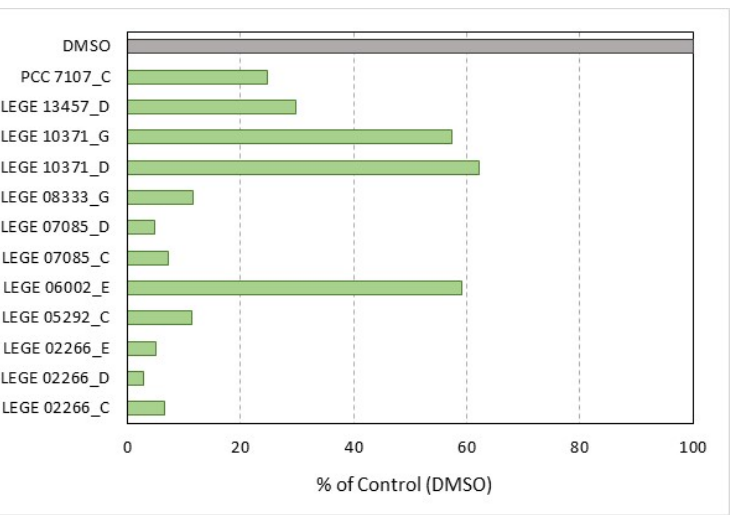
Figure 6. Firefly luciferase (Fluc) luminescence values observed in cells exposed to 12 specific fractions of 8 cyanobacteria strains. These values were particularly low when compared to solvent control (DMSO). Cells were transfected with the constitutively expressed vectors mpFN26A[Fluc/PPAR α ], mpFN26A[Fluc/PPAR β ] and mpFN26[Fluc; PPAR γ ] and pGL4.35[Nluc]. DMSO concentration did not exceed 0.5 % per well. Results are shown as percentage DMSO luminescence (100%). The strains identified to have low Fluc raw luminescence were looked at for the presence of cyanotoxins in the genus, but its presence is not documented [24], which may indicate that the toxicity is due to other compounds than cyanotoxins. The fraction C of Phormidium sp. LEGE 05292 has been used as a positive control for cytotoxicity in other